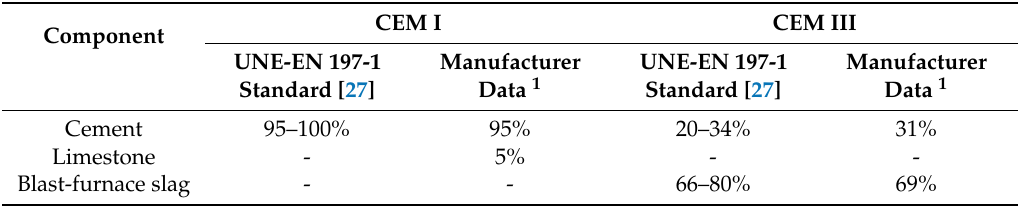
Table 1. Components of the commercial cements